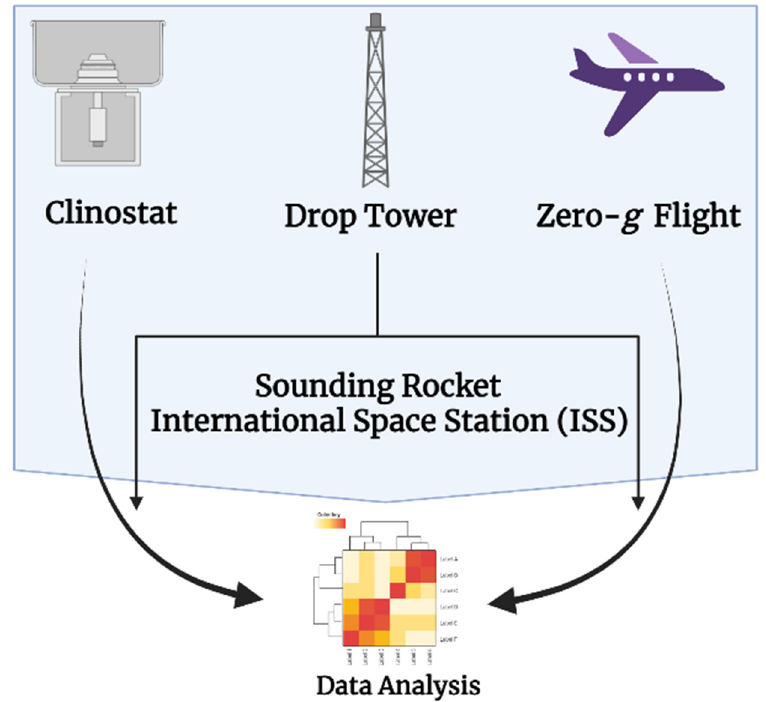
Figure 3. Pictographic representation of some platforms used for microgravity simulations on Earth and lower orbit. Arrows indicate the samples from different platforms that are collected and sent for experimentation and data analysis (Figure was created with help of BioRender.com) (accessed on 02 June 2022).